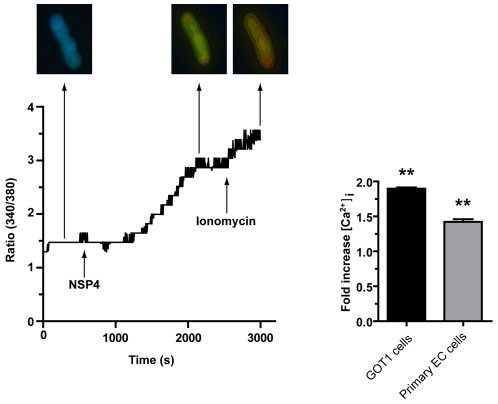
NSP4 induces an increase in intracellular Ca2+ in human EC tumor cells.GOT1 and primary EC t.c. were loaded with Fura-2 and Ca2+ measured before and after the addition of recombinant NSP4 (2 µM), for 40 min (GOT1 n = 8 cells, primary EC n = 10 cells). The asterisk (*) denotes statistical significance (P<0.01; Wilcoxon's rank sign test).